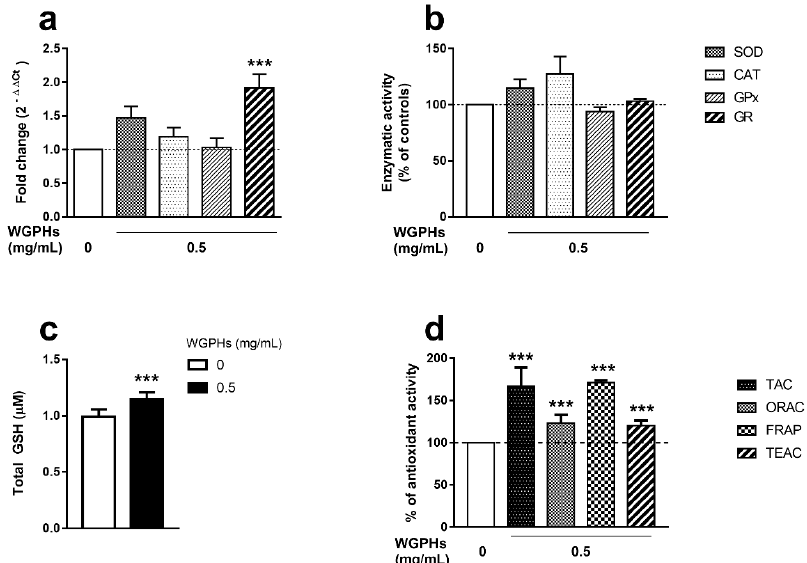
Figure 4. ( a ) Relative gene expression of superoxide dismutase (SOD), catalase (CAT), glutathione peroxidase (GPx), and glutathione reductase (GR) in non-stimulated PBMCs after overnight treatment with 0.5 mg / mL WGPHs. The data represent the mean of the values calculated with respect to PHA-stimulated, untreated cells with the 2 − ∆∆ Ct method, and the standard error of the mean of each group ( n = 39). ( b ) Enzyme activities of SOD, CAT, GPx, and GR in the supernatants from the same cultures. Activities are expressed as a percentage of the controls. The data represent the mean and standard error of the mean of each group ( n = 32). ( c ) Total glutathione (GSH) content (µM) in non-stimulated PBMCs after overnight treatment with 0.5 mg / mL WGPHs. The data represent the mean of the GSH content and standard error of the mean of each group ( n = 28). ( d ) Total antioxidant capacity (TAC), oxygen radical absorbance capacity (ORAC), ferric reducing antioxidant power (FRAP), and trolox equivalent antioxidant capacity (TEAC) quantified on the supernatants from non-stimulated PBMCs cultured overnight with 0.5 mg / mL WGPHs. The data are expressed as a percentage of the control group, and they represent the mean and standard error of the mean of the percentage of each group ( n = 32). *** p ≤ 0.001 with respect to the control group (WGPHs 0 mg /